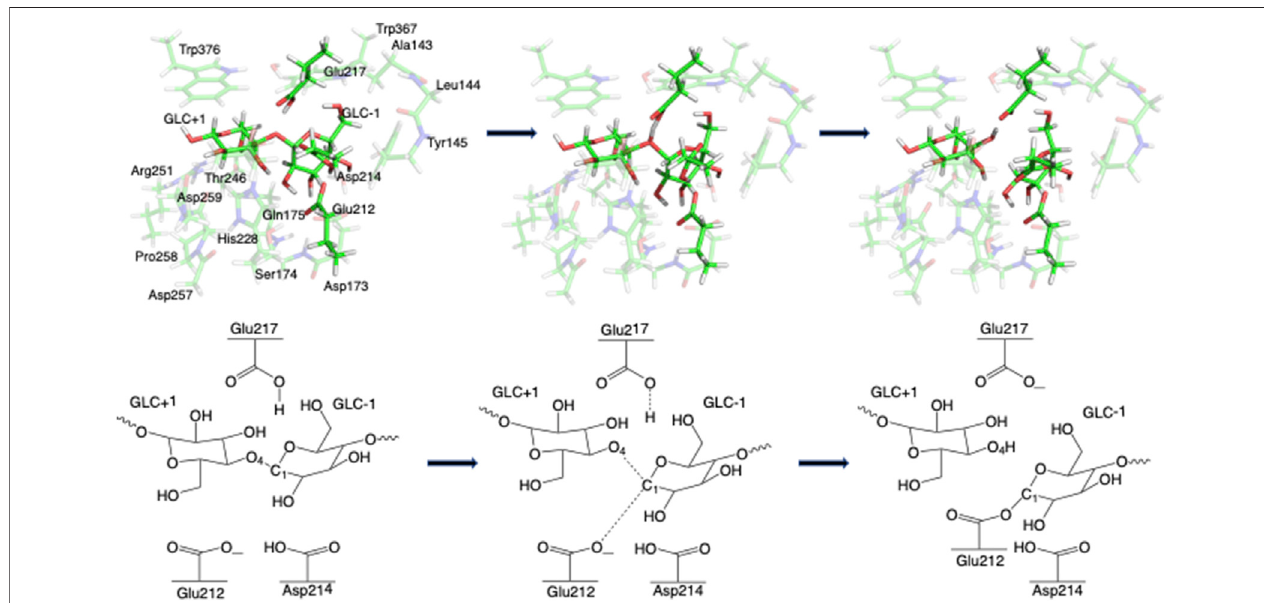
FIGURE 3 | 3D and 2D representation of glycosylation reaction mechanism of the Res21-E model of 8CEL.